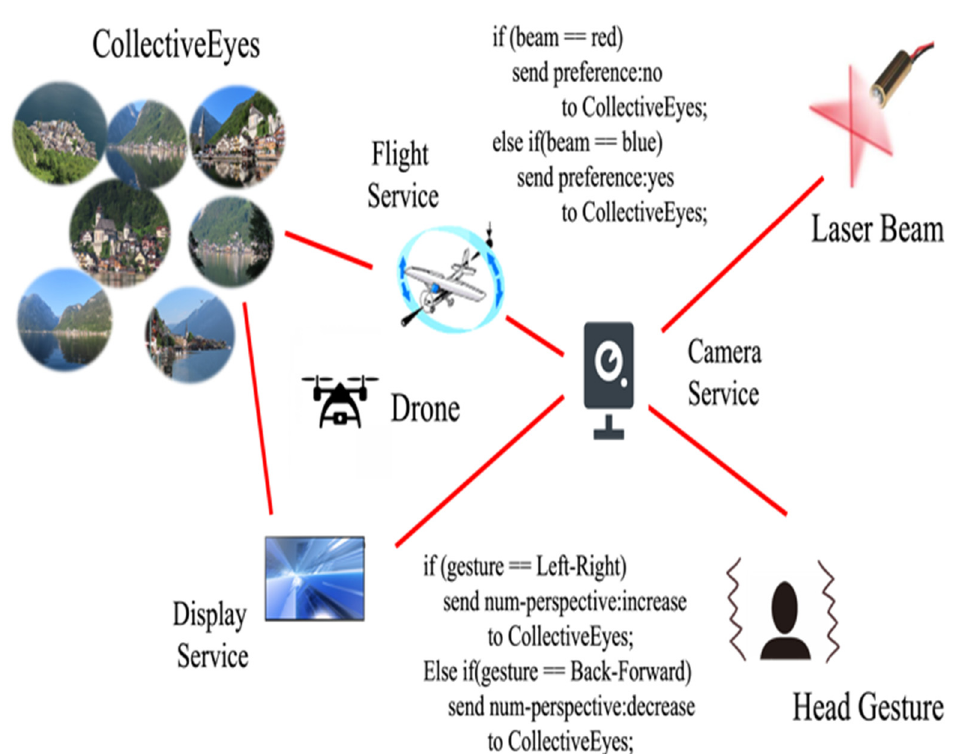
Figure 8. A Configuration Example.